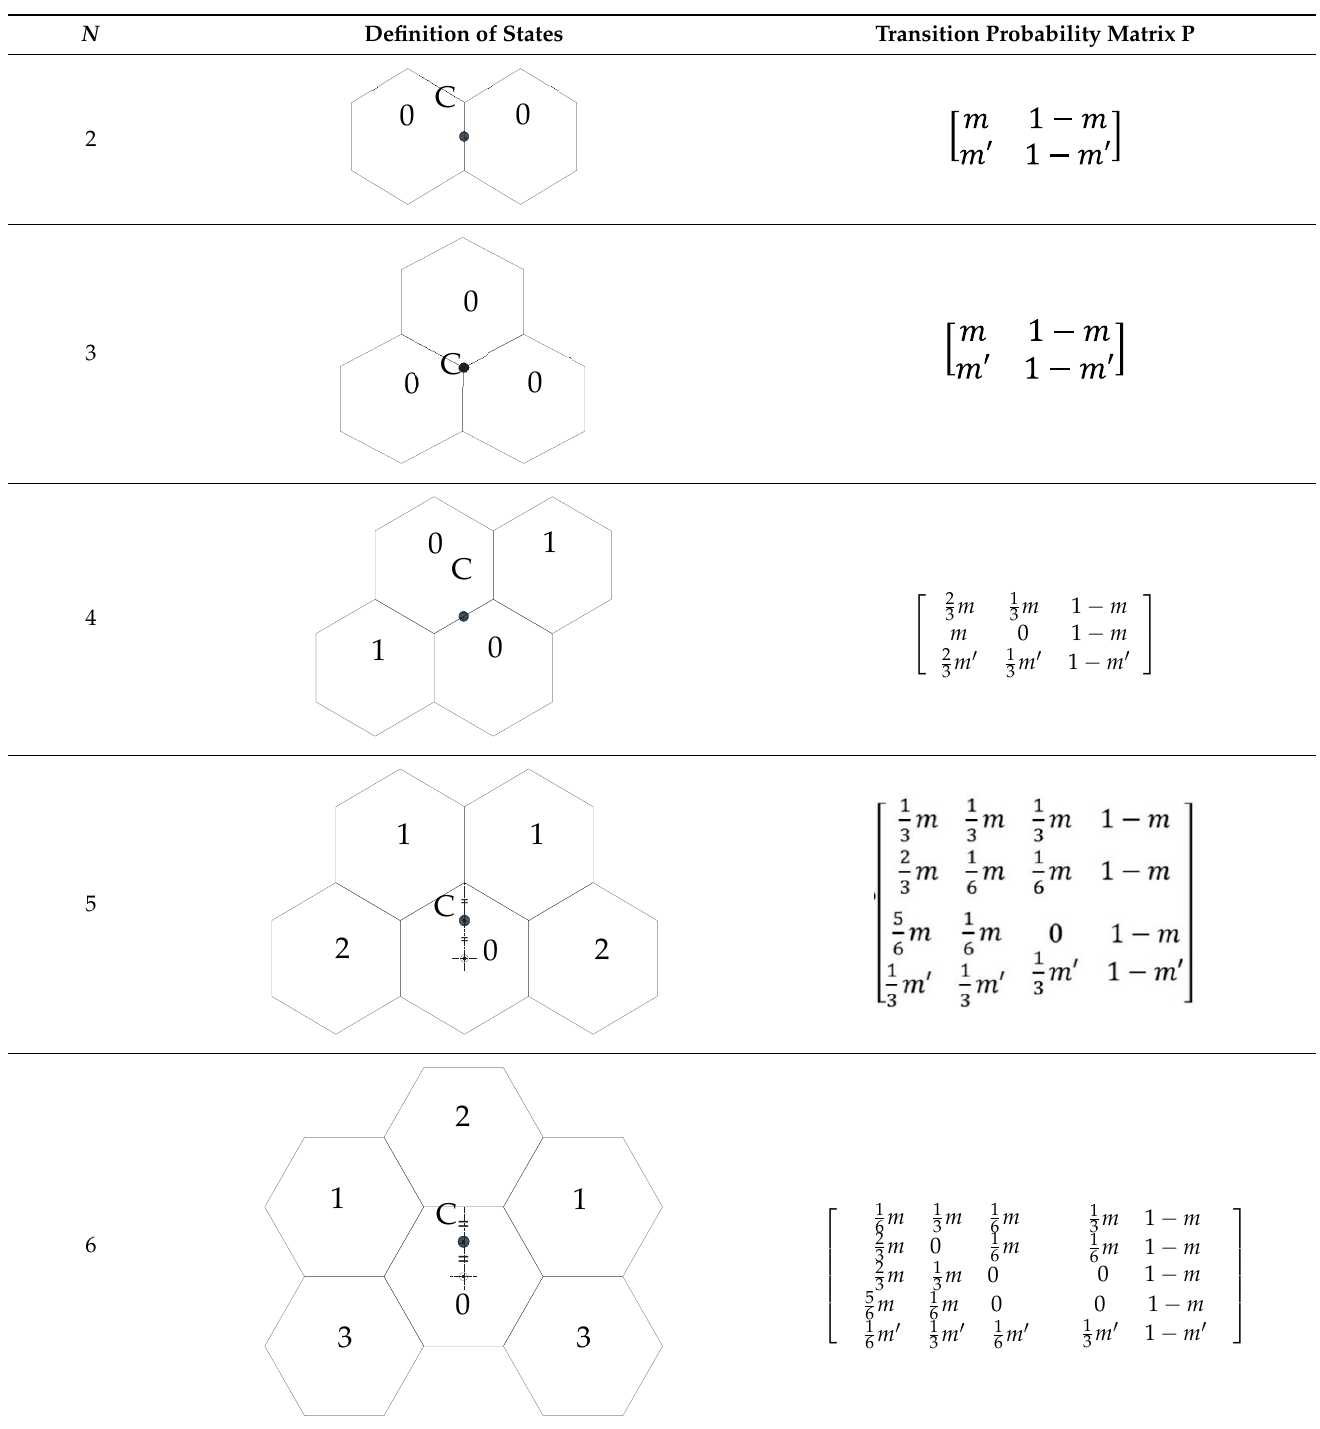
Table 2. State of each cell in location area and transition probability matrix for various N.